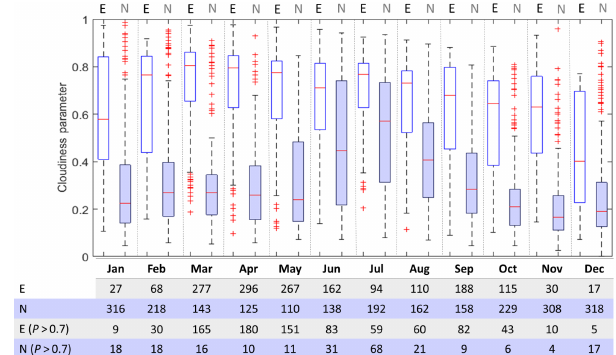
Figure 2. Monthly variation of cloudiness daily (09:00–12:00) me- dians and percentiles recorded during NPF events (E; white) and nonevents (N; shaded). Numbers below the plot correspond to the number of data points included in each box plot. Number of clear- sky events (E ( P >0.7)) and clear-sky nonevents (N ( P >0.7)) ac- company the plot. See Fig. 1 for an explanation of symbols.